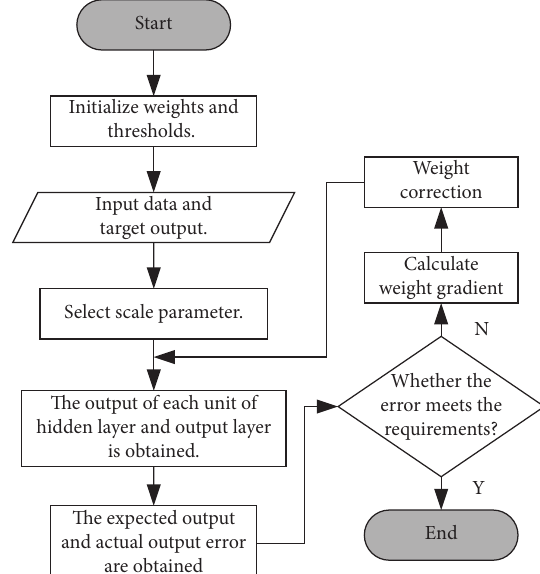
Figure 3: Overall training process of facial expression recognition